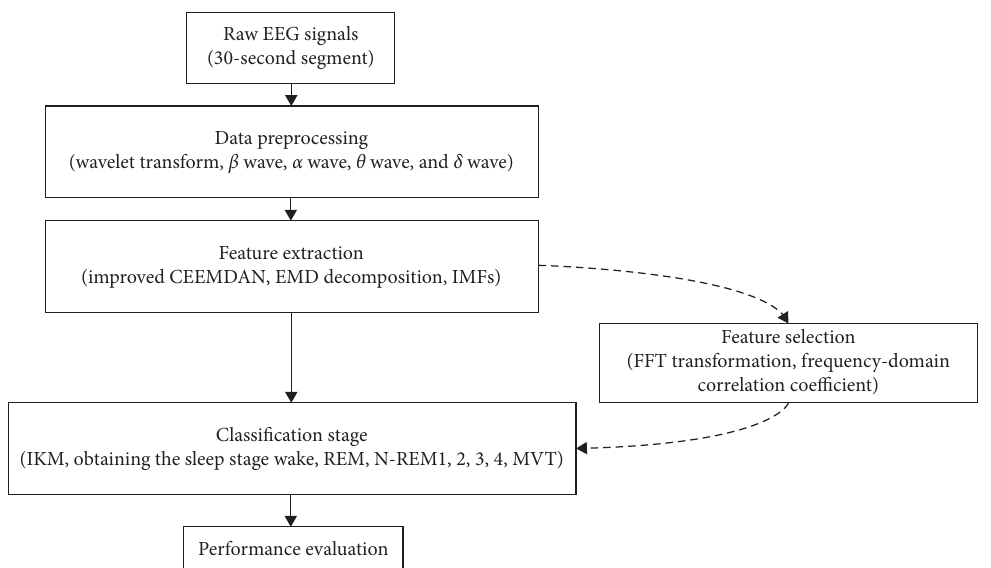
Figure 1: Automatic sleep stage classification based on